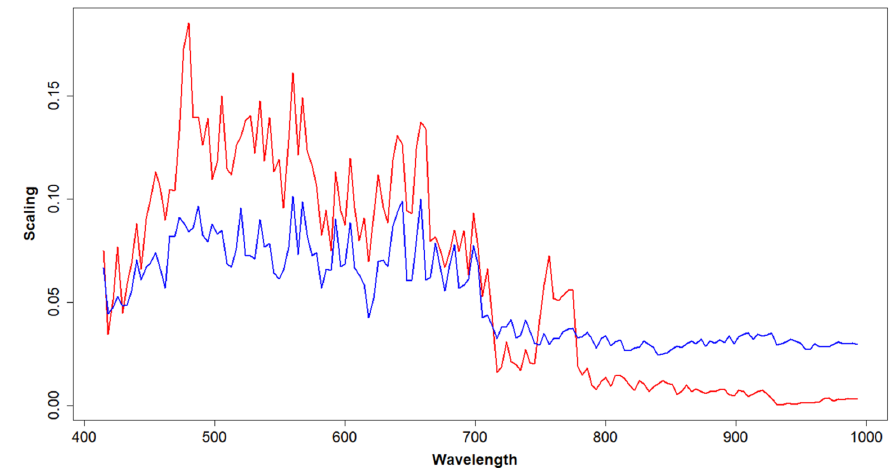
Figure 5. Sum of absolute scaling values over the spectrum from linear combinations. Blue and red lines represent L1b Spa.F, norm., Sha.R and L1c Spa.F, norm., Sha.R data respectively.